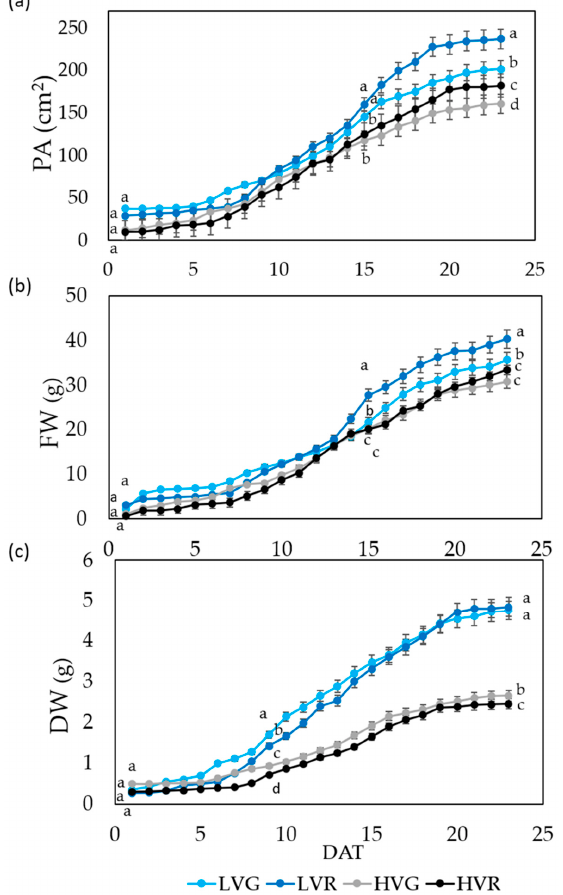
Figure 2. Growth curves of green (G) and red (R) lettuces under low (LV) and high (HV) VPD in terms of plant area ( a ), fresh weight ( b ) and dry weight ( c ). Mean values (n = 9) ± standard errors are shown. Different letters correspond to significantly different values among treatments within a given date, according to Tukey’s HSD ( p ≤ 0.05).